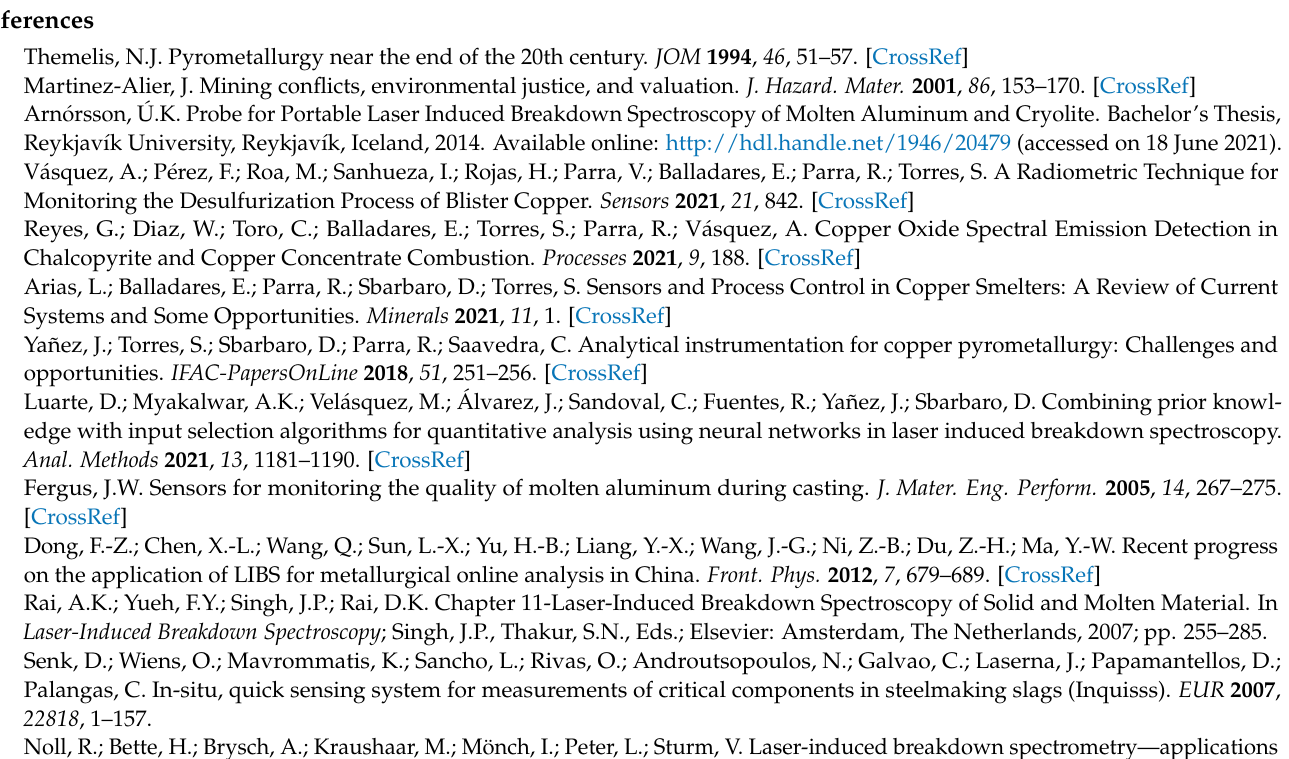
Figure A1. Number of publications on LIBS and molten-phase metals in time intervals of their submission.